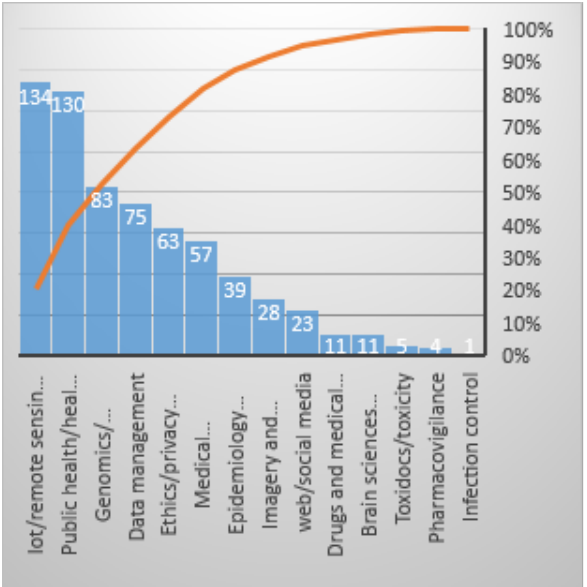
Figure 1. Pareto diagram of publications per Family of topics